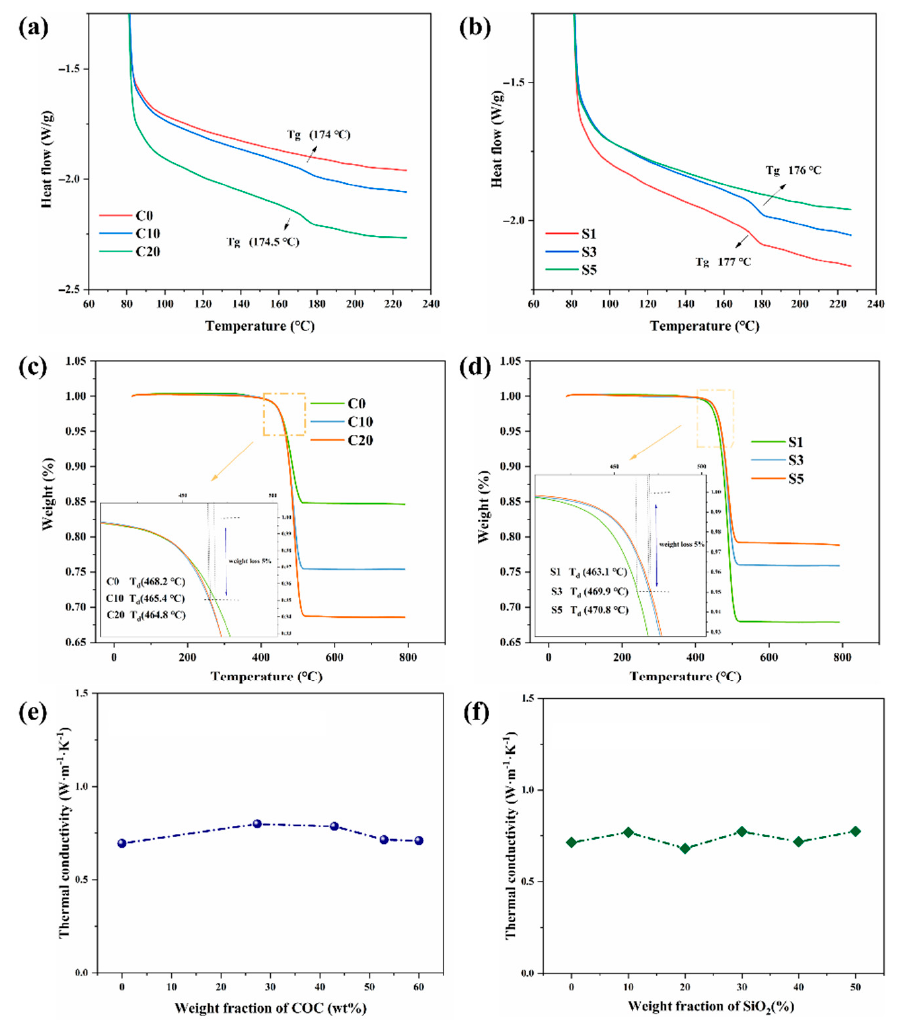
Figure 6. DSC curves of ( a ) C0, C10, C20 and ( b ) S1, S3, S5; TGA thermograms of ( c ) C0, C10, C20 and ( d ) S1, S3, S5; influence of the content of COC ( e ) and SiO 2 ( f ) on the in ‐ plane thermal conduc ‐ tivity.